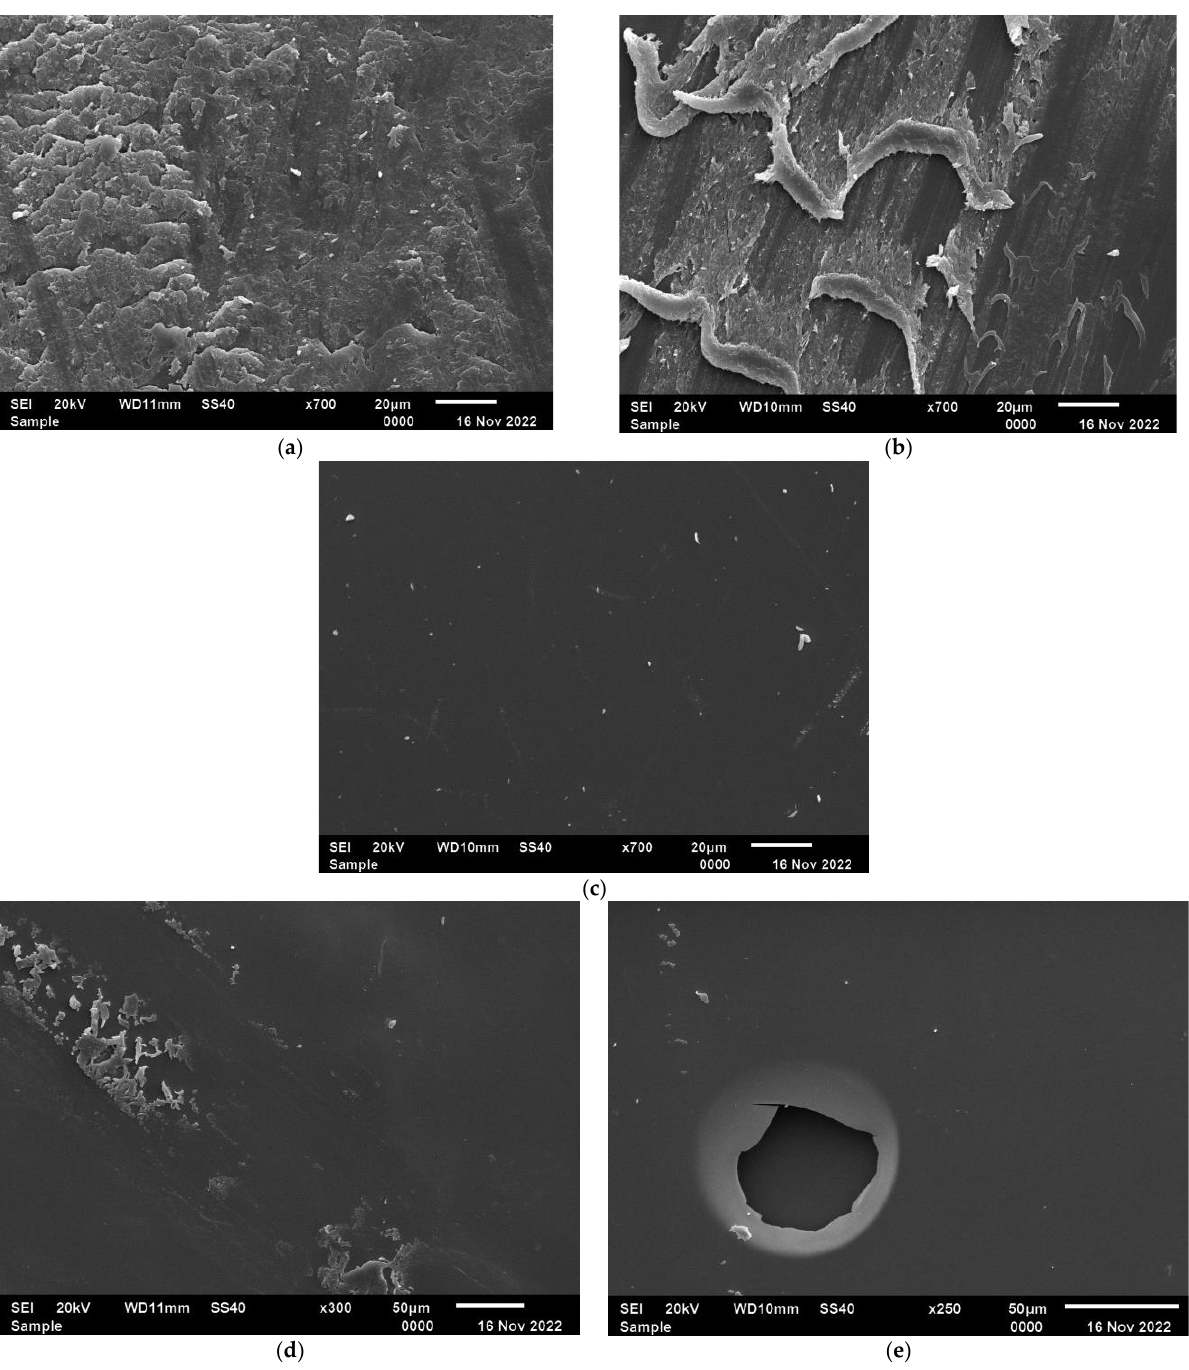
Figure 3. SEM images of surface of Na-CMC ( a ), Na-CMC- g -PDMAEMA ( b ), ficin ( c ) and its conjugates with Na-CMC ( d ) and Na-CMC- g -PDMAEMA ( e ). The FTIR data correlate with the docking results. Figure 4a demonstrates the spectra of Na-CMC and its conjugate with ficin. The FTIR spectrum of Na-CMC contains a number of characteristic absorption bands at 1069 and 1080 and ones at 1327, 1414, and 1593 cm − 1 , cor- responding to vibrations of pyranose cycles and dissociated carboxylic, respectively [33–35]. The FTIR spectra of the Na-CMC and ficin conjugate contain the same bands; additionally, ficin amid I band appeared as a shoulder on the left side of the 1593 cm − 1 band.Besides, the significant shifts and shape-changing of the two-mode band describing pyranose cycle vibrations are observed. This also confirms the conjugate formation and involvement